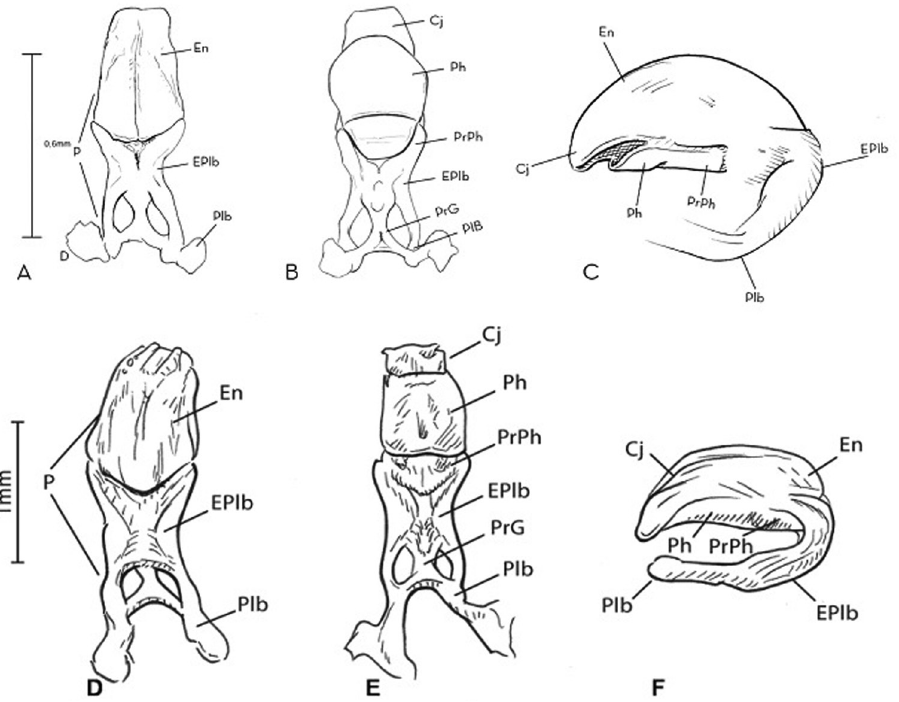
Figure 7. Phallus of R. marabaensis sp. n. ( A dorsal view B ventral view C lateral view) and R. robustus ( D dorsal view E ventral view F lateral view). Cj: conjunctive; En: endosome; EPlb; median extencion of basal plate; P: phallus; Plb: basal plate; PrG: gonopore process; PrPh: phallossoma process; Ph: